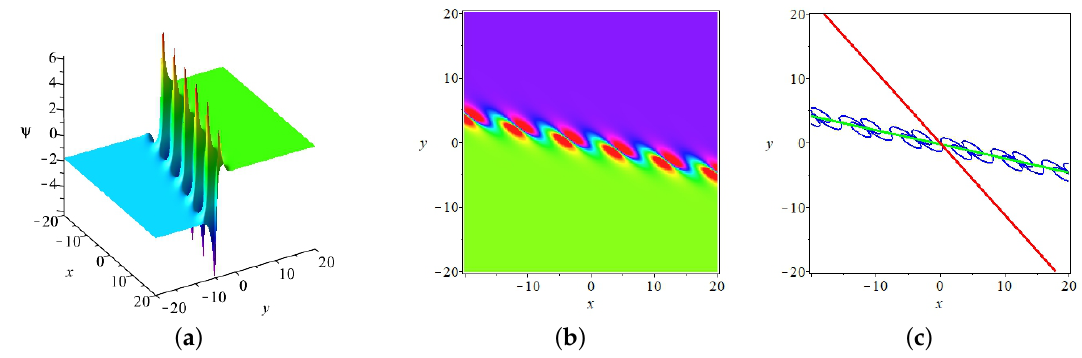
Figure 1. (Color online) One-breather solution (9) with r 2 = r 3 = r 4 = r 6 = r 7 = r 8 = 1, a 1 = 0.3, b 1 = 1, c 1 = 1.2, d 1 = − 1, e 1 = 1, f 1 = 1, β 1 = 2, γ 1 = 0, κ 1 = 0. ( a ) The three-dimensional stereograms when t = 0, z = 0. ( b ) the corresponding contour figure. ( c ) Characteristic lines figure, the red line (0.3 x + 1.36 y + 0.3659935070 = 0) and the green line ( x + 0.9 y = 0) are two characteristic lines of